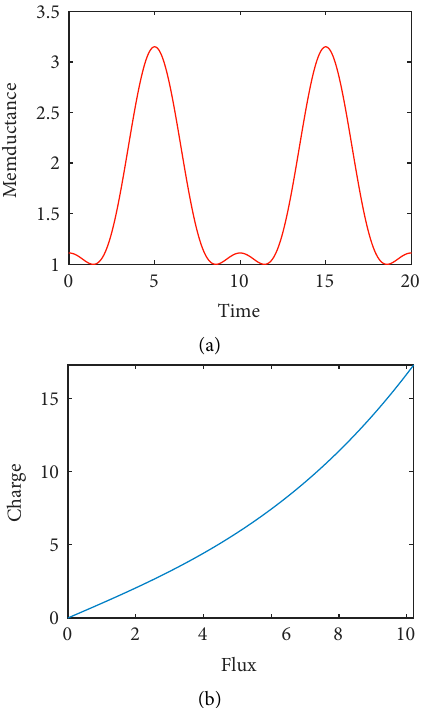
Figure 2: (a) Timing diagram of memductance. (b) Flux‐charge characteristics of the Figure 3: Equivalent circuit of the